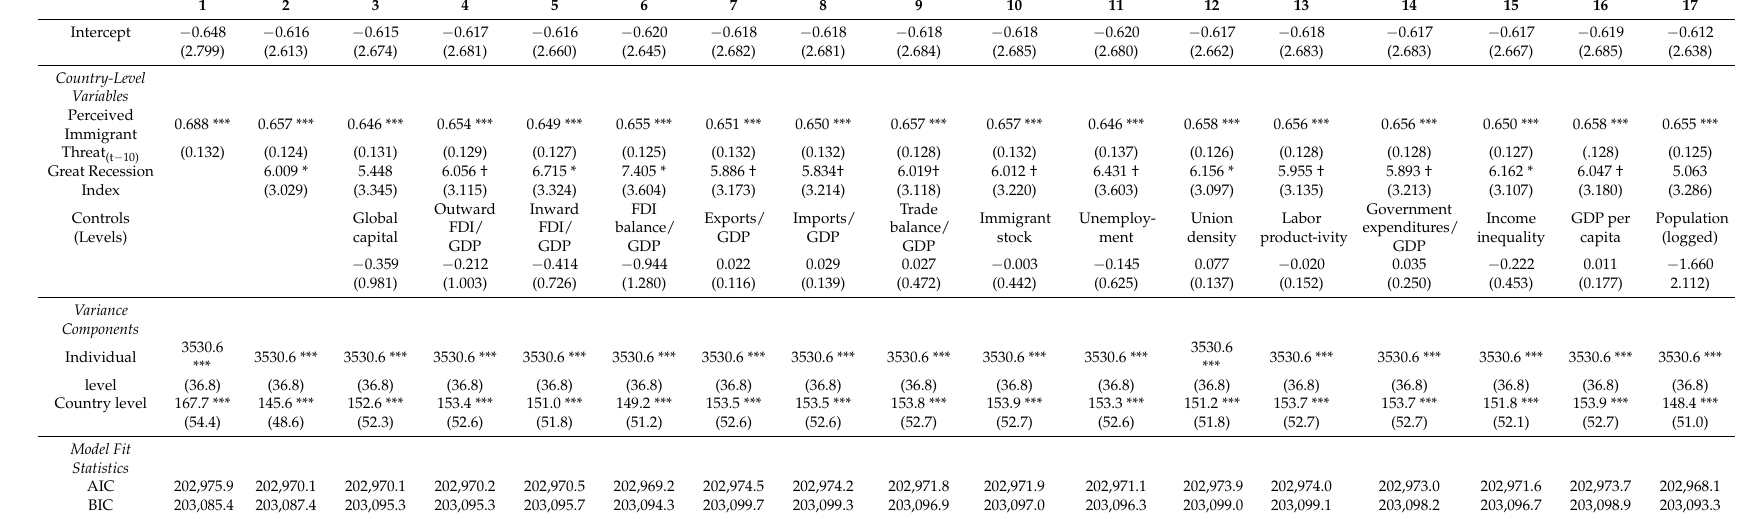
Table 5. Determinants of perceived immigrant threat controlling for levels of country-level variables, 2013 ( n = 18,433 individuals nested within 22 countries). 1,2,3